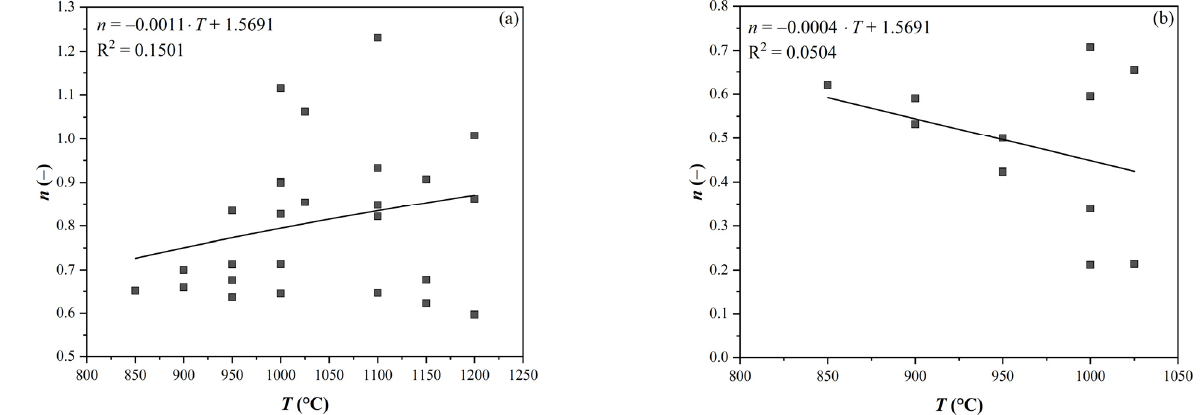
Figure 3. Effect of temperature on the n value: ( a ) without SIP and ( b ) with